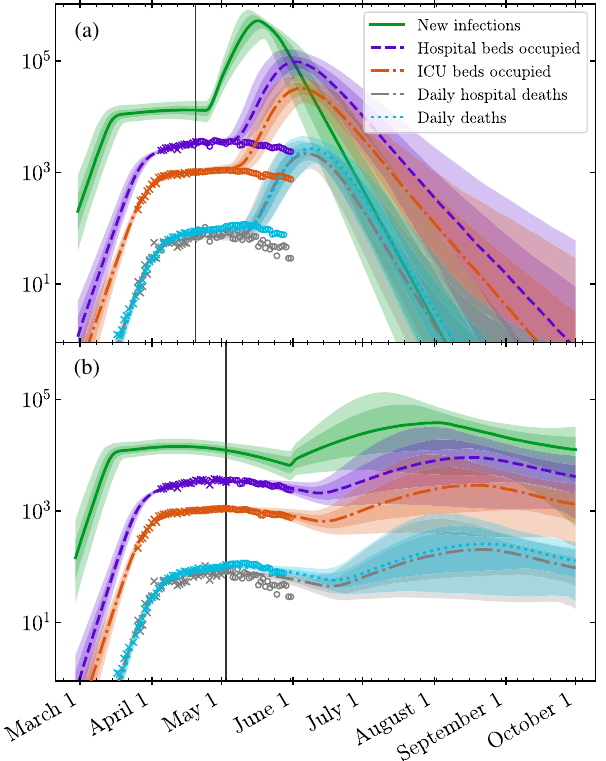
FIG. 8. Simulation of different scenarios for relaxation of the stay-at-home order for the entire state of Illinois. Each panel ’ s vertical line marks the end of data used for calibration. We display two scenarios: (a) where the mitigation actor M ð t Þ returns to 1 on April 24, 2020, corresponding to a complete lack of social distancing, and (b) where on June 1, 2020, the effect of NPIs is reduced by